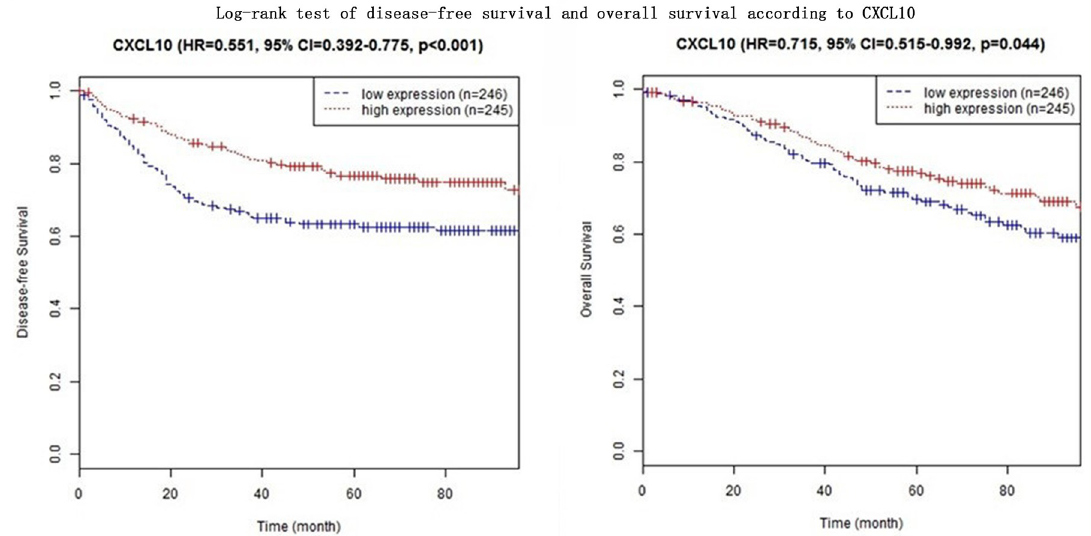
Fig 2. Log-rank test of disease-free survival and overall survival according to CXCL10.